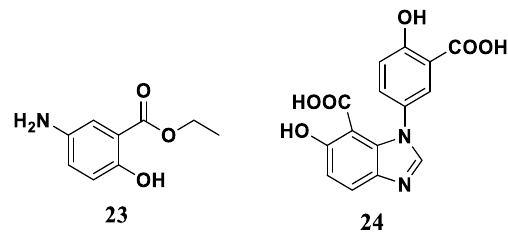
Figure 4. Structures of side-products 23 and 24 .